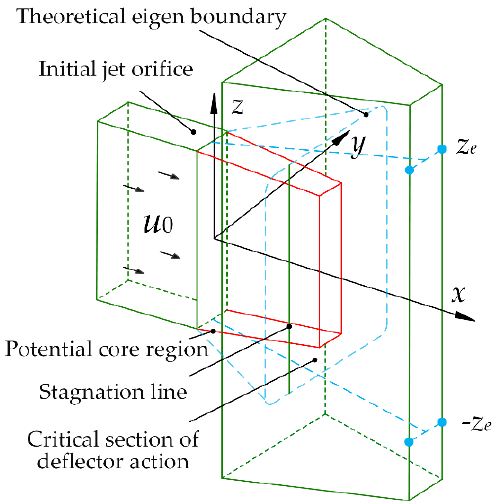
Figure 3. Early-terminated initial jet in deflector.